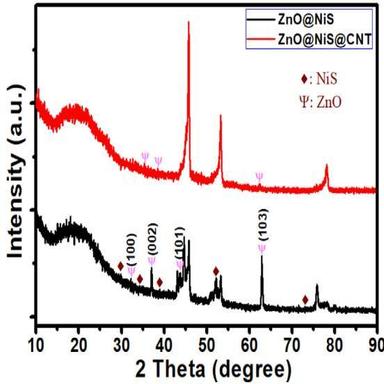
XRD patterns of ZnO/NiS and ZnO/NiS/CNT electrodes on nickel foam substrates.